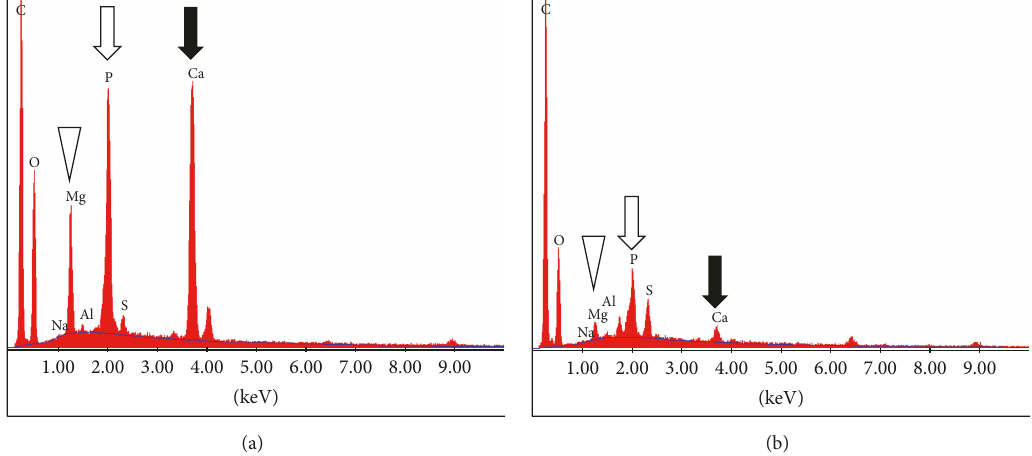
Figure 6: Spectra obtained using energy-dispersive X-ray spectroscopy. Calcium, magnesium, and phosphate exist in the enterolith piece immersed in double-distilled water (a). The amount of these elements was decreased in the piece immersed in the citric acid solution